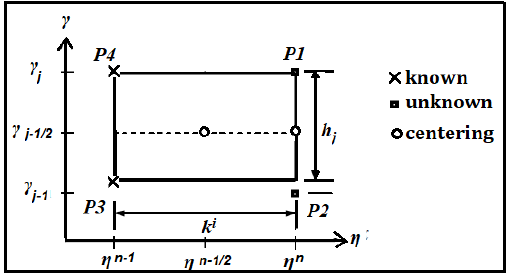
Figure 2. The rectangle of difference method.